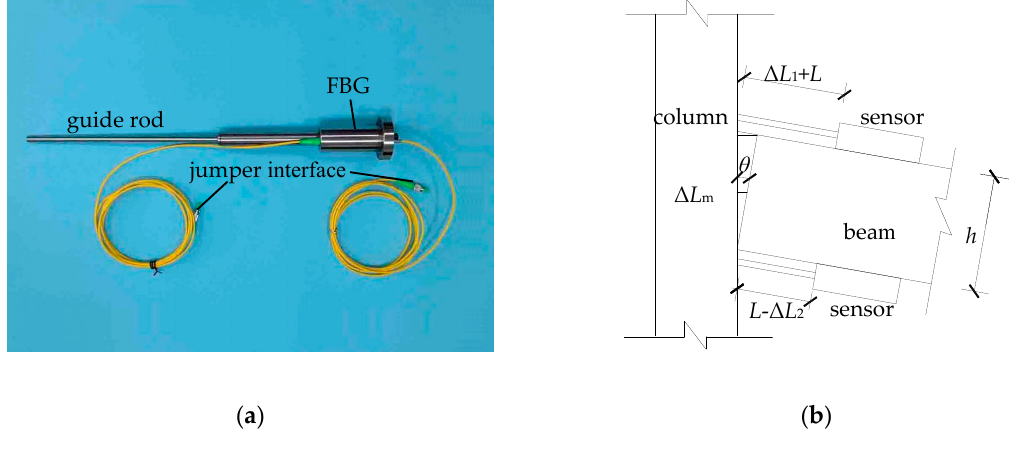
Figure 8. ( a ) FBG displacement sensor; ( b ) Sensor arrangement.